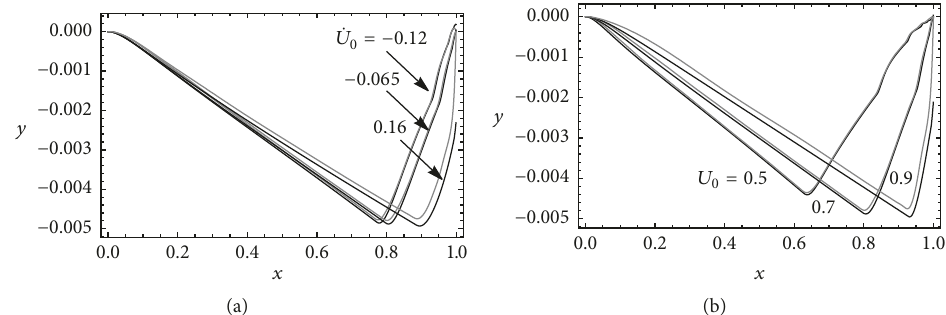
Figure 3: Comparison between the integral approach (black lines) and the Galerkin approach (gray lines), when 𝑃 = 0.01 and 𝜇 = 0.1 ; ̇𝑈 𝑁 = 3000 and 𝑁 = 30 : (a) 𝑈 = 0.7 and ̇𝑈 𝑈 = −0.065 𝑠 𝑒 0 0 variable; (b) 0 variable and 0